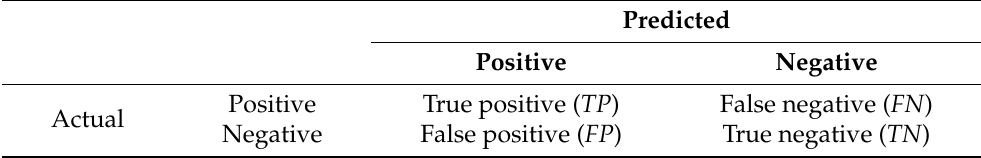
Table 1. Confusion